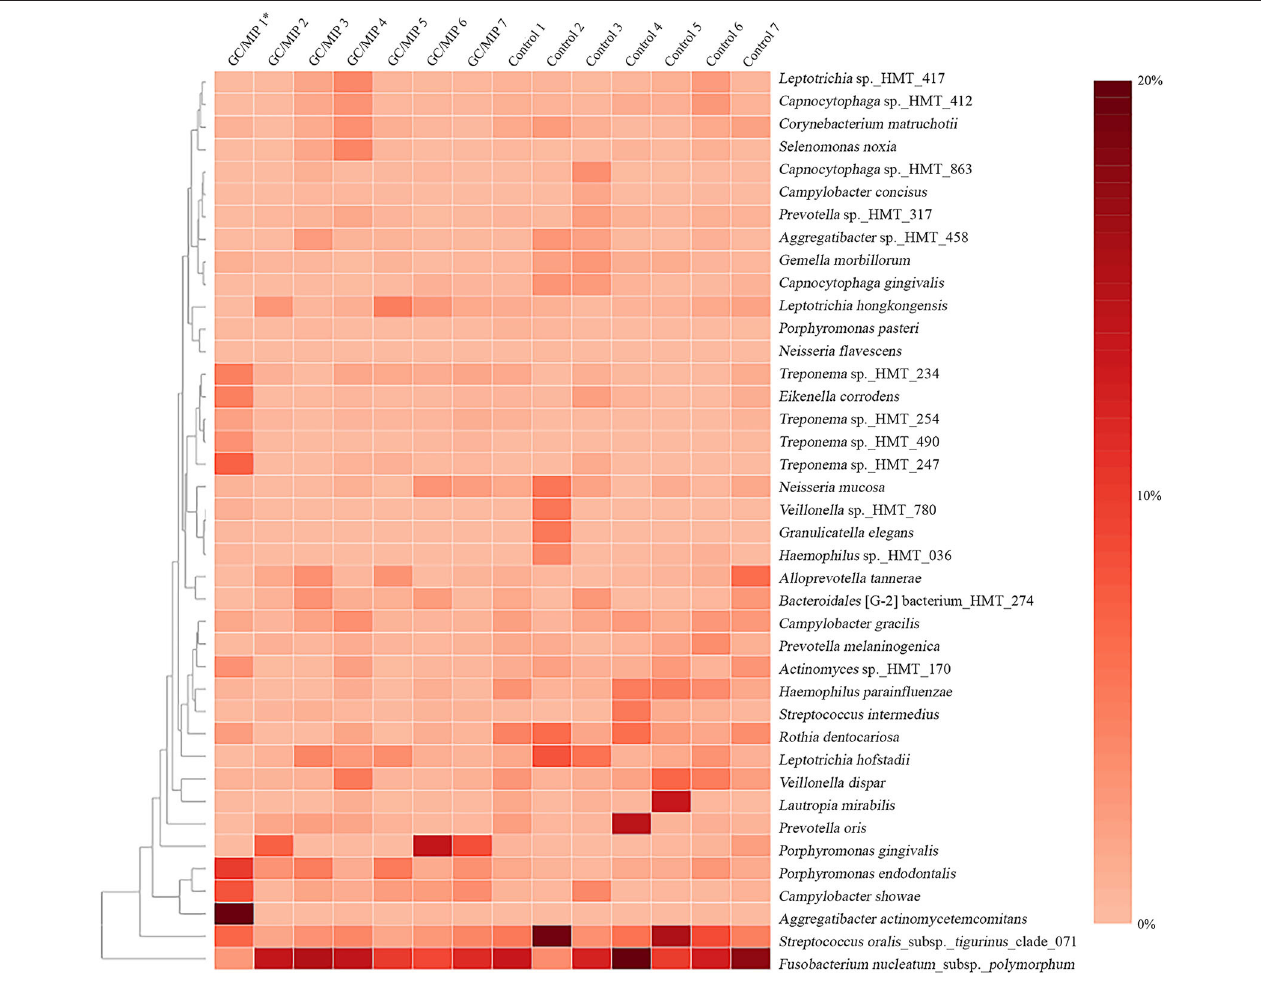
FIGURE 5 | Heat map based on the relative abundance of the 40 most abundant species in the subgingival biofilm of individuals with GC/MIP and Control. Species relative abundance of subgingival affected sites of GC/MIP (SbA_GC/MIP) was compared to subgingival sites of Control (SbH_Control). *Patient harboring Aa JP2-like +